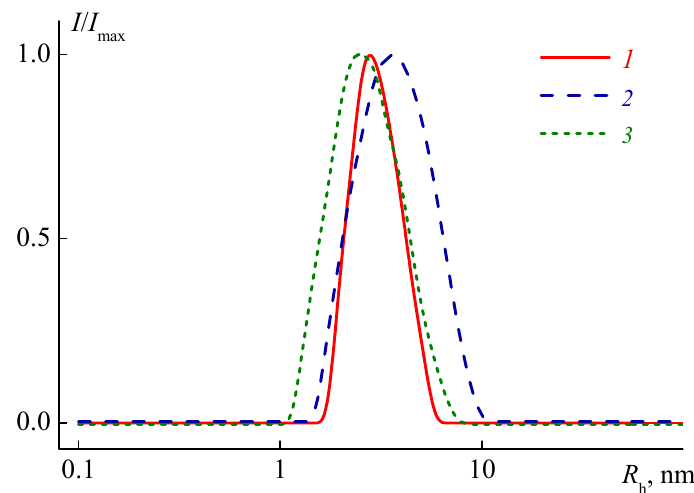
Figure 1. The dependencies of relative intensity I / I max of scattered light on the hydrodynamic radii R h of scattering species for 2-nitropropane solutions of C8A-(PiPrOx-b-PEtOx) at c = 0.040 g·cm − 3 (1) C8A-(PEtOx-b-PiPrOx) at c =0.063 g·cm − 3 (2) and C8A-P(EtOx-grad-iPrOx) at c = 0.069 g·cm − 3 (3) I max is the maximum value of light scattering intensity I at a given polymer concentration.